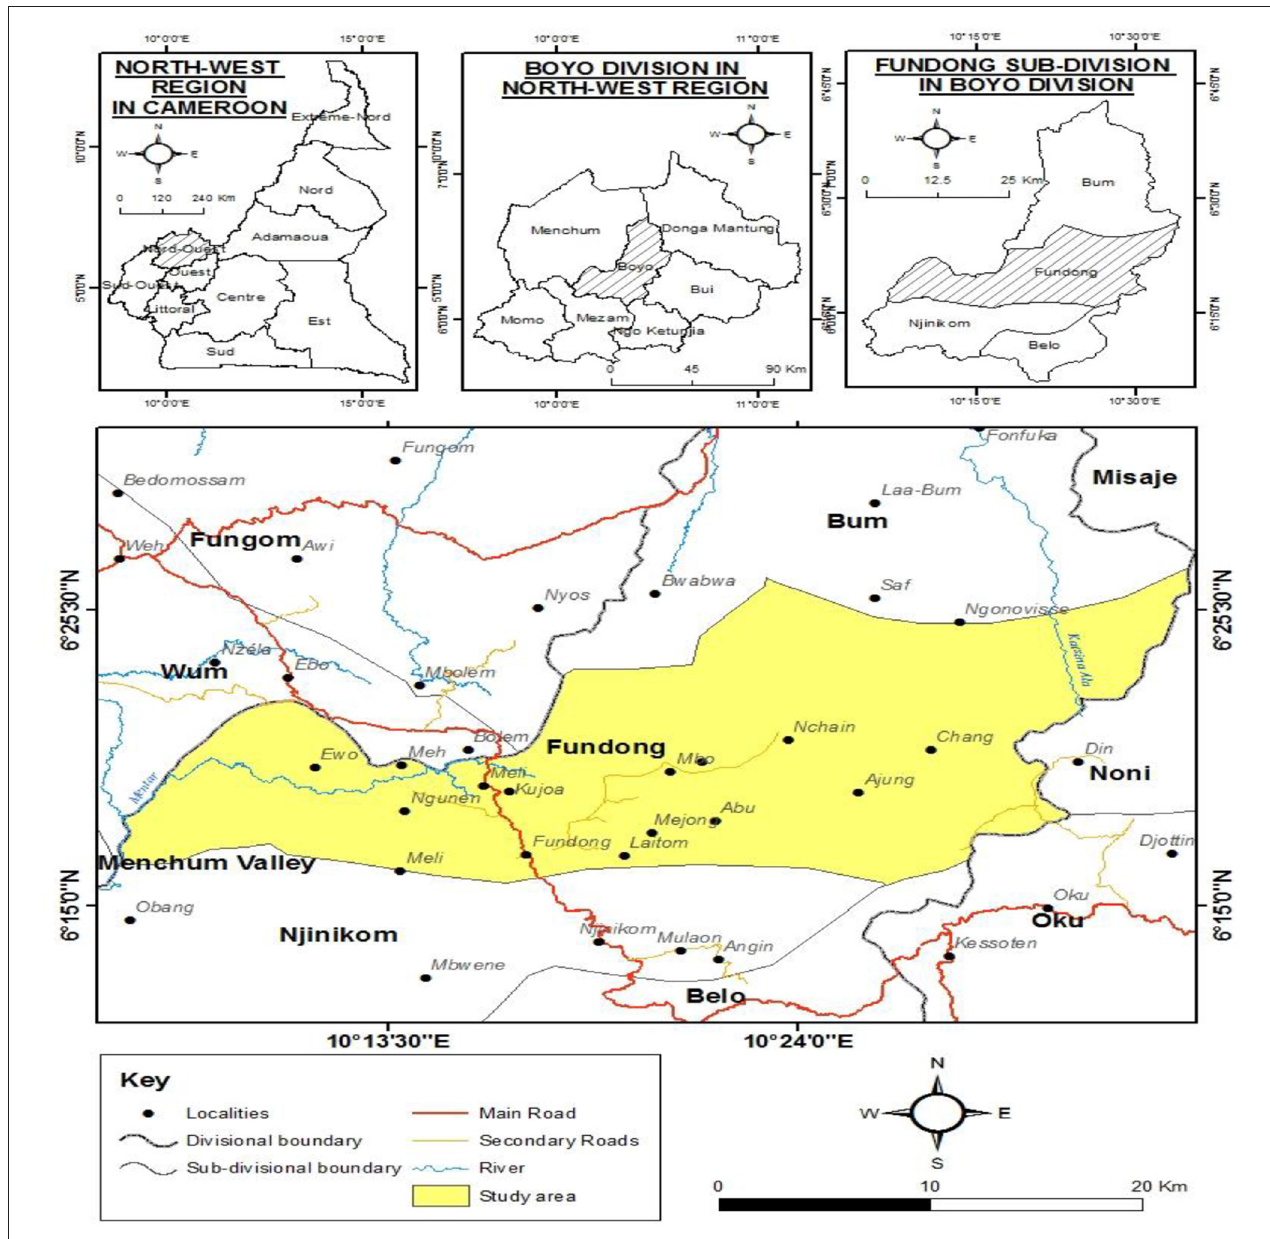
FIGURE 1 | The study